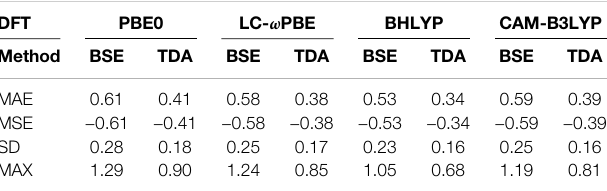
TABLE 1 | Mean average error (MAE), mean signed error (MSE), standard deviation (SD), and maximum error (MAX) of ev GW /BSE@DFT ( “ BSE ” )